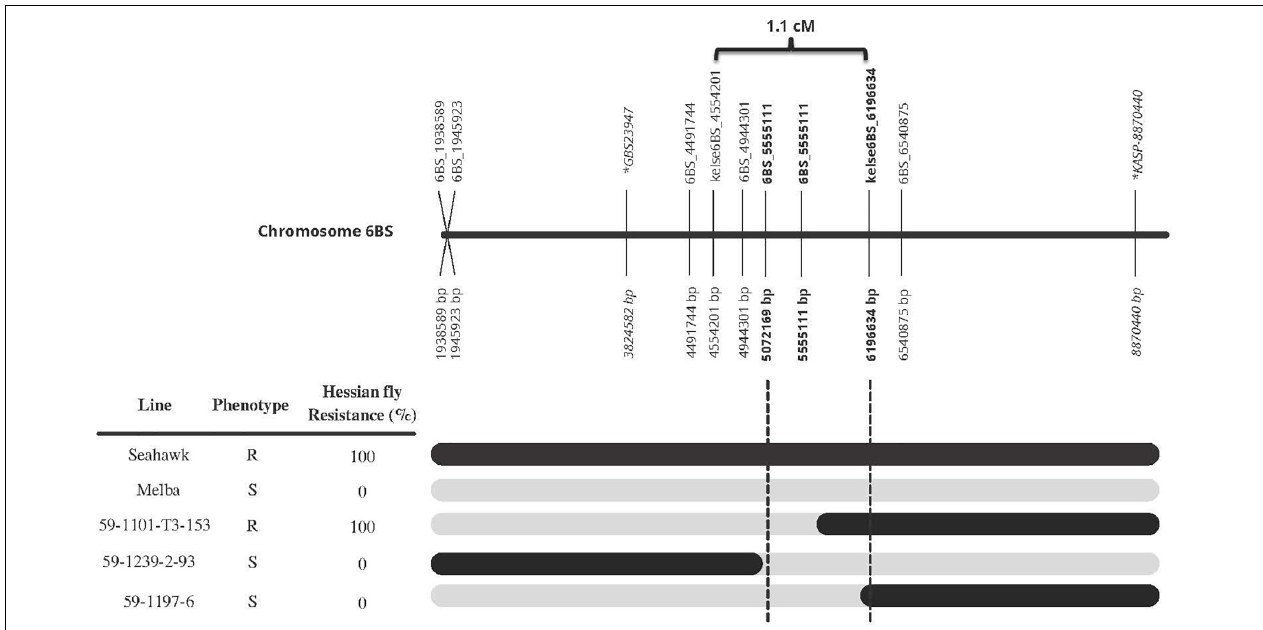
FIGURE 4 | Fine-mapping of HKelse to the 1.1 Mb region between 5072169 and 6196634 bp on chromosome 6B, based on the genotype and phenotype of three recombinant lines. Black bars represent Seahawk allele while gray represents Melba. All base pairs (bp) are in relation to IWGSC RefSeq v1.0. Markers in bold are flanking the resistance loci found in Kelse and Seahawk. Markers in italic with an * in front of name are the flanking markers for the resistance loci in Chokwang (Zhang et al., 2021). Marker 6BS_5555111 mapped to the reference genome at 5072169 bp and 5555111bp, both are displayed is the figure. The 1.1 cM distance for markers kelse6BS_4554201 and kelse6BS_6196634 was calculated off the ∼ 2000 F 2 individuals from the Seahawk/Melba